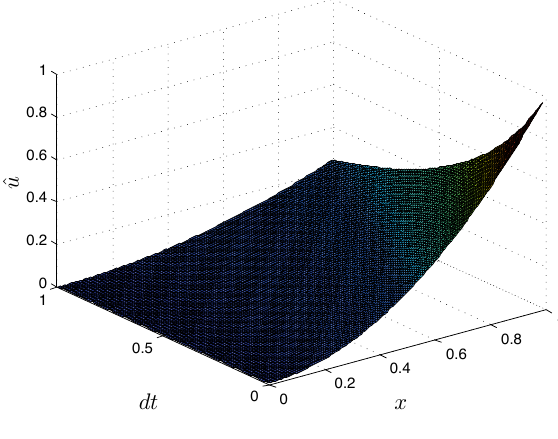
Fig. 3. 2D plot of the approximate solution for Test Problem 5